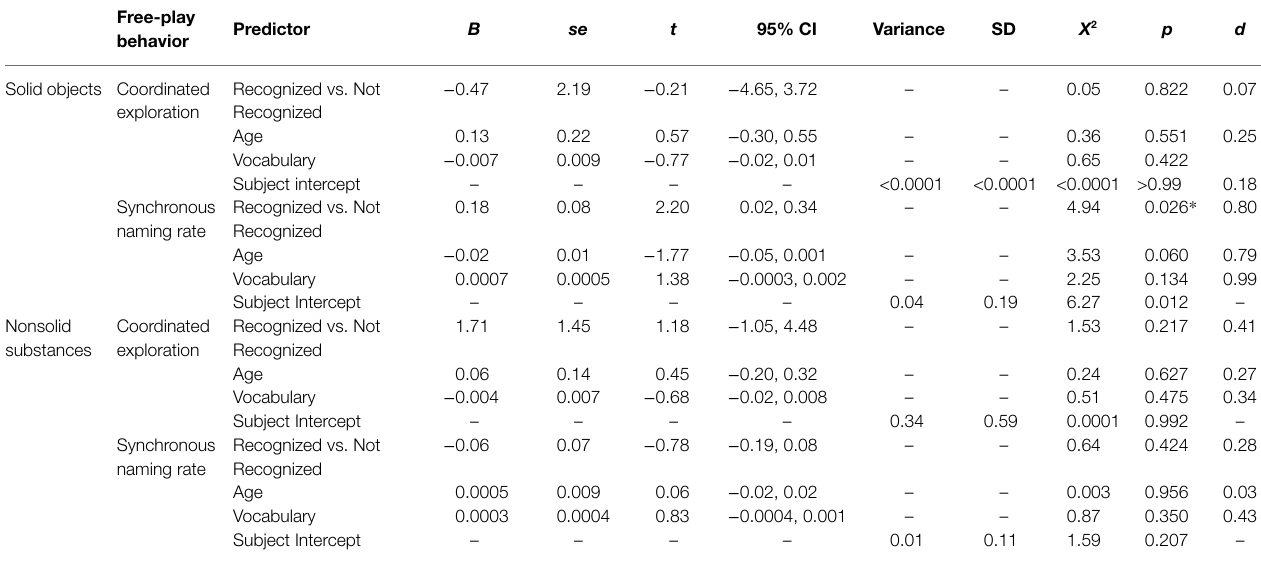
TABLE 2 | Results from mixed effects regression analyses comparing differences in free-play behavior related to recognition accuracy.